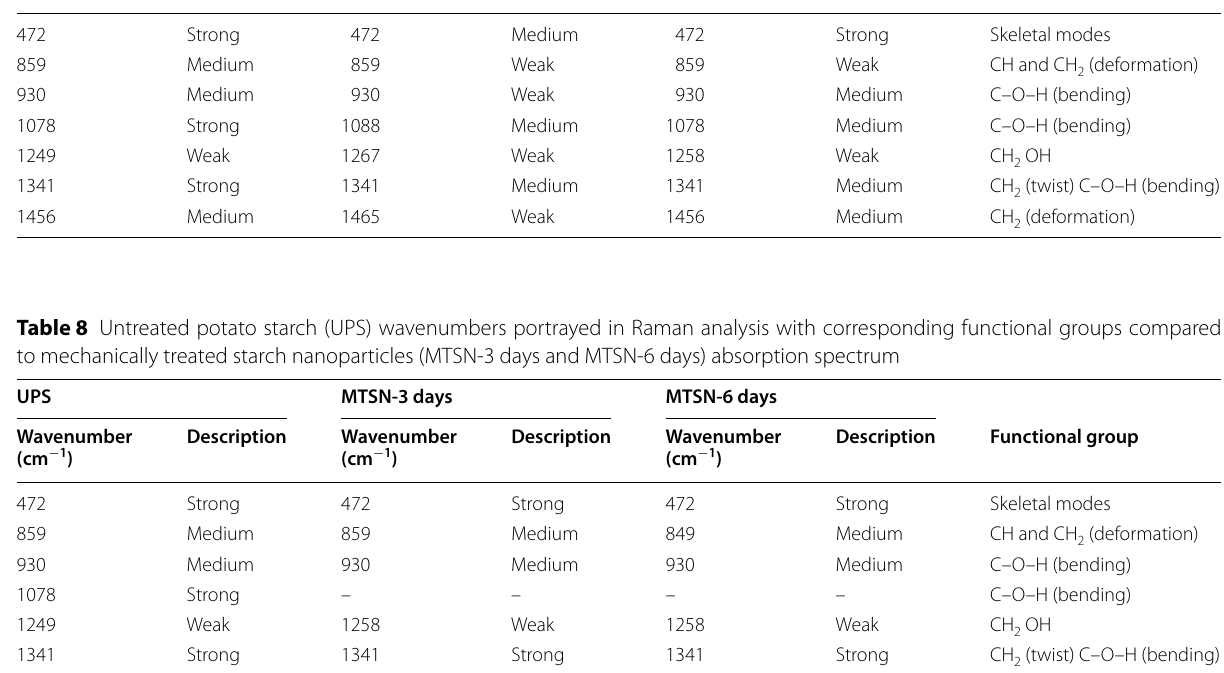
Table 9 Release times of ciprofloxacin-loaded untreated potato starch and starch nanoparticles